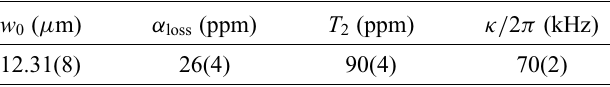
TABLE I. Key cavity parameters. w 0 , cavity waist; α loss , unwanted cavity loss; T 2 , output-mirror transmission; κ , cavity decay rate (half width at half